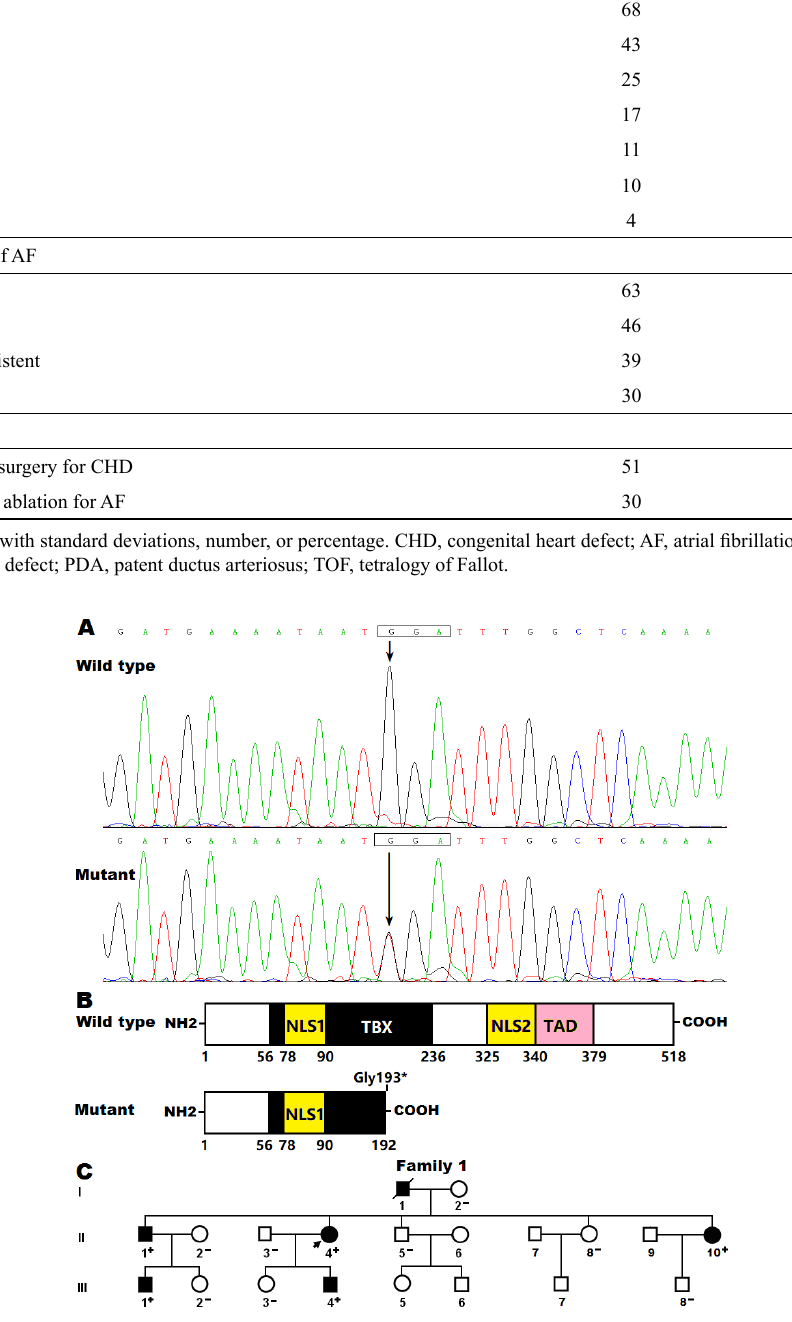
Figure 1 – A new TBX5 mutation responsible for familial heart defect and atrial fibrillation. (A) Sequence chromatograms illustrating the TBX5 heterozygous mutation from the proband (mutant) and its homozygous wild-type control from a healthy individual (wild type). An arrow points to the heterozygous nucleotides of G/T or the homozygous nucleotides of G/G. (B) Schematic drawings showing the structural domains of the TBX5 proteins. NH2, amino- terminus; NLS1, nuclear location signal 1; TBX, T-box; TAD, transcriptional activation domain; NLS2, nuclear location signal 2; COOH, carboxyl-terminus. (C) Pedigree structure of the family suffering from congenital heart defect and atrial fibrillation. Family members are recognized by generations as well as numbers. Circles mean female members; squares, male family member; closed symbols, affected members; open symbols, unaffected members; the symbol with a slash, the deceased member; the arrow beside the closed square, the index patient; “+”, carriers of the TBX5 mutation; “–”,